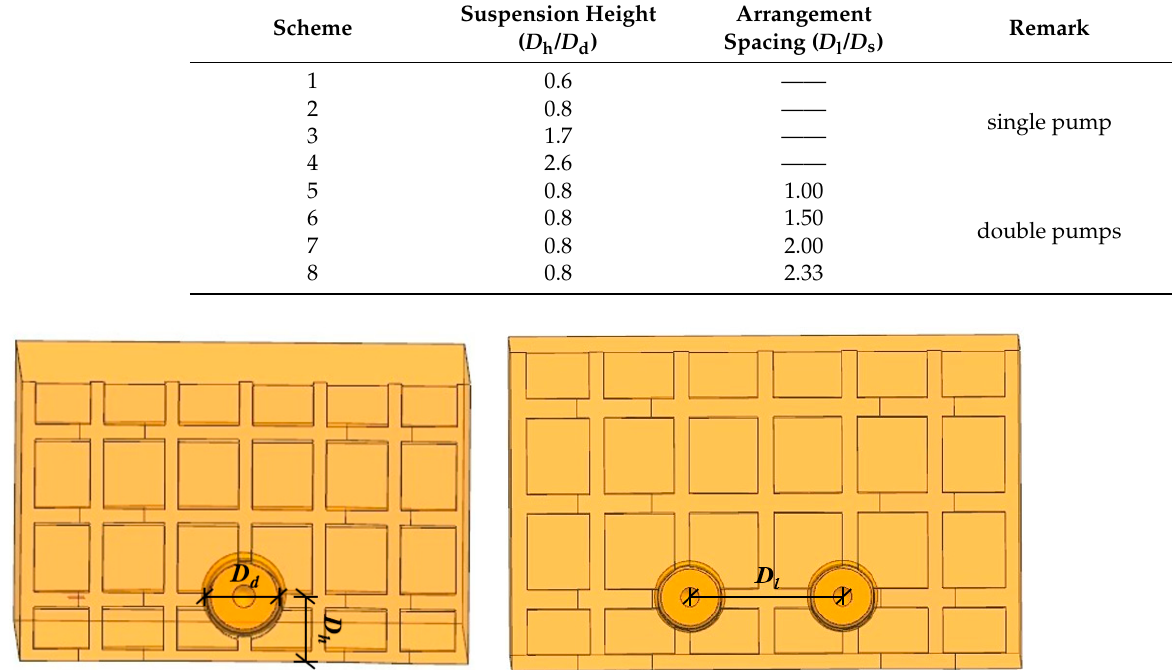
Figure 6. Chart of suspended height and layout distance of the new integrated pump gate.